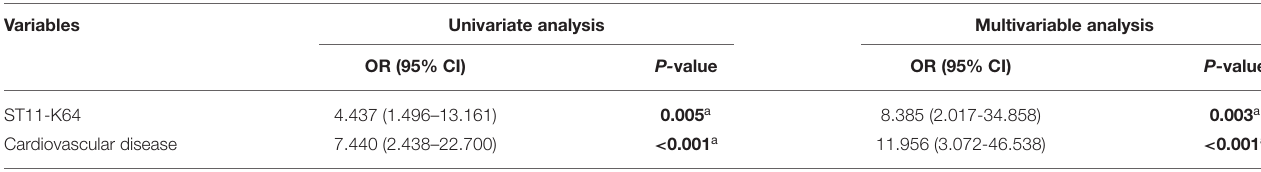
TABLE 3 | Univariate and multivariate logistic regression analysis of CR-hvKP infections.